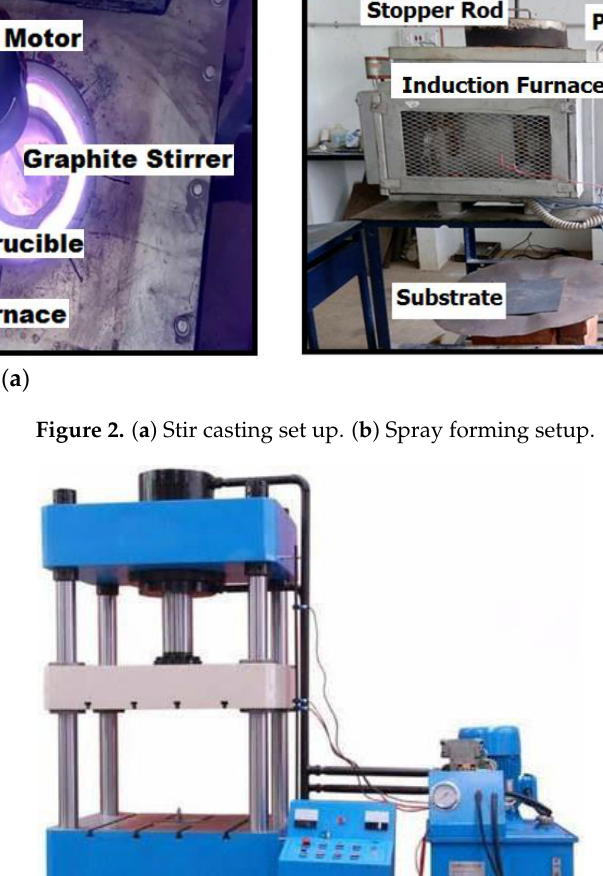
Figure 2. ( a ) Stir casting set up. ( b ) Spray forming setup.